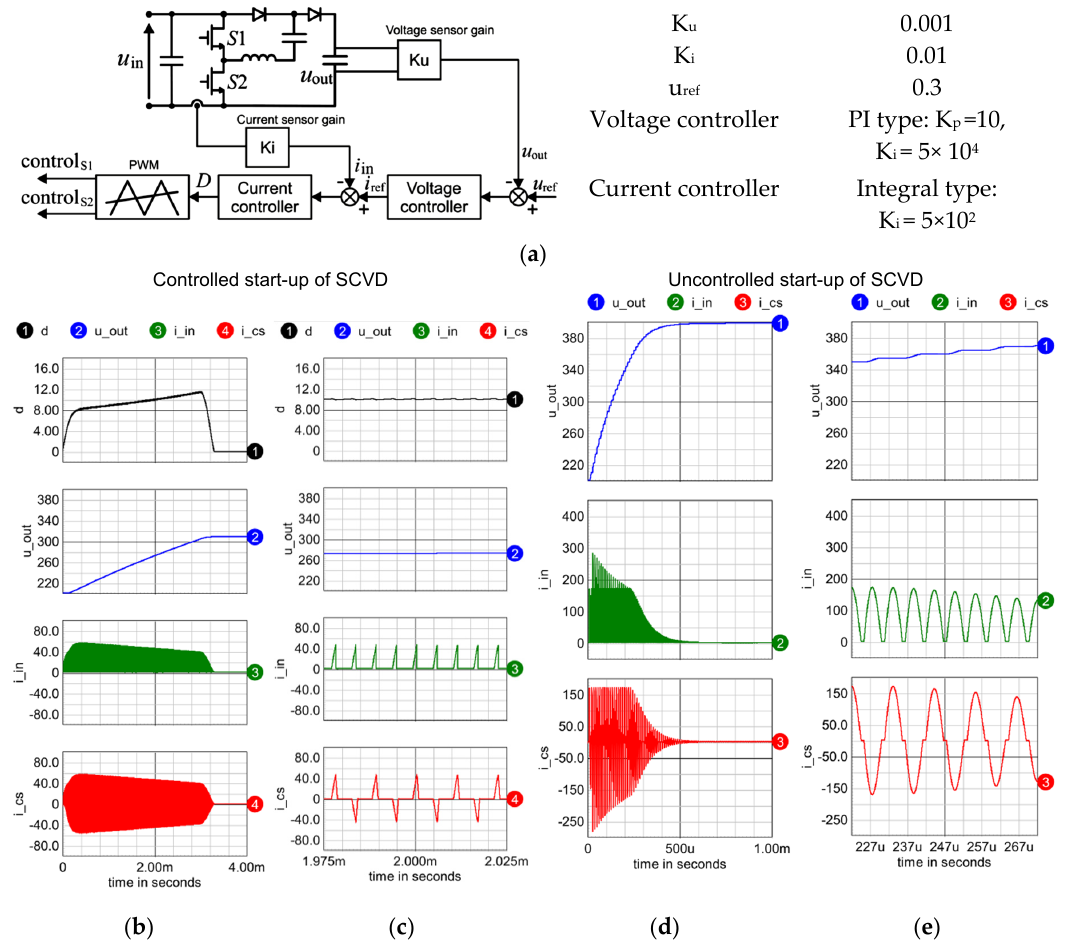
Figure 8. ( a ) Closed-loop voltage control system with overcurrent protection and its parameters (pattern P3 with the duty ratio control D = T 1 / T S –Table 1). ( b , c ) Controlled start-up of SCVD under pattern P3 in the closed-loop system and uncontrolled start-up of SCVD under pattern P1. Waveforms of duty cycle (symbol d (%)), output voltage u out (V), input current i in (A), current i Cs (A) of capacitor C in the cases: ( b , d ) full range, ( c , e ) zoom. ICAP/4 simulation results. Circuit parameters as in Table 3.